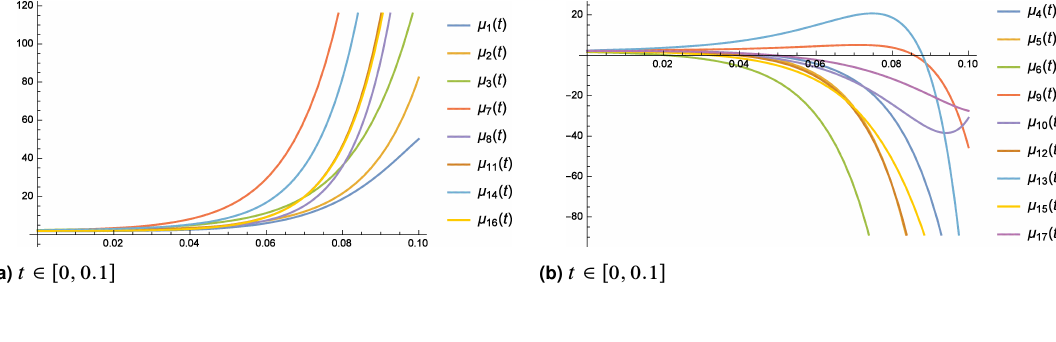
Fig. 6. The second phase of the state of the stock markets. In (a) two stock markets recover their affected states, and in (b) three stock markets stop resisting and get affected by the crisis.